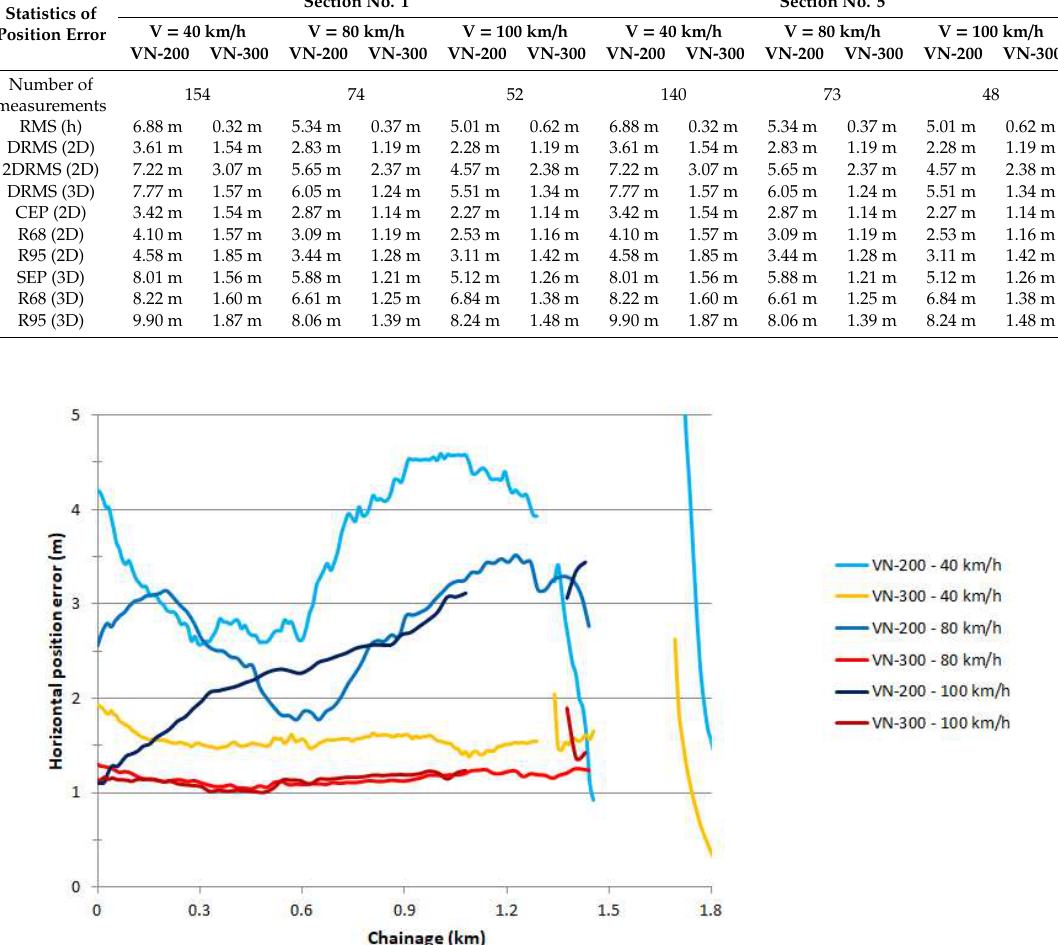
Figure 7. Variability in the two-dimensional (2D) position errors recorded by the VN-200 and VN-300 devices as a function of the route length when travelling at speeds of 40 km/h, 80 km/h and 100 km/h along section no. 1.